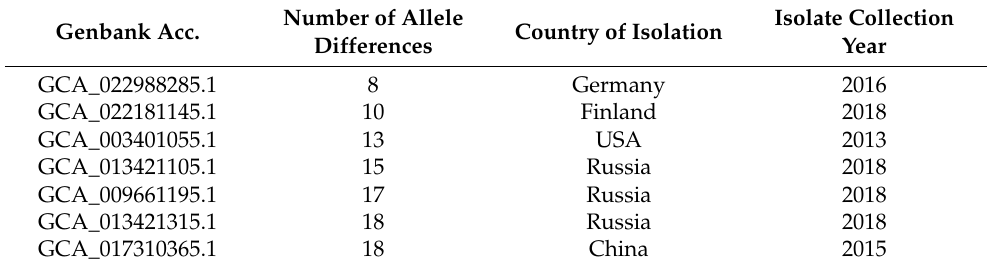
Table 3. Reference isolates from Genbank, with closest matches to the isolates studied according to cgMLST